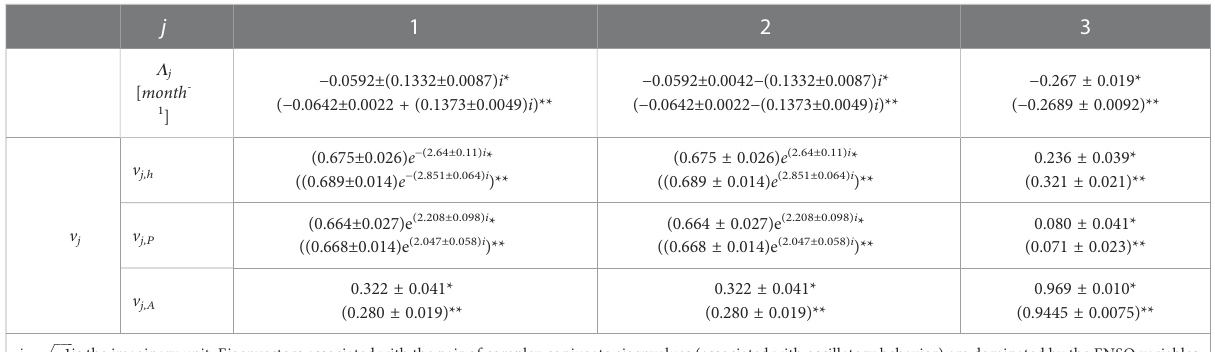
TABLE 5 Eigenvalues L j and their respective eigenvectors v j (1-standard-deviation con fi dence intervals) for the matrix of coef fi cients for the three-variable ENSO-Atlantic ReOsc+ model (Eq. 3 fi tted as explained in Section 2.4) for SODA (marked with *) and ORA-20C (with parenthesis, marked with **) reanalysis in the 1971-2000